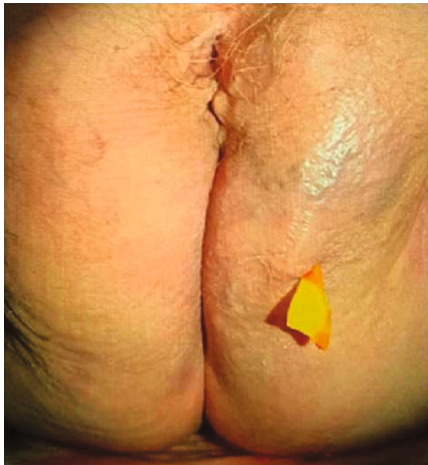
1: Incision site of the labia majora with an impaired healing